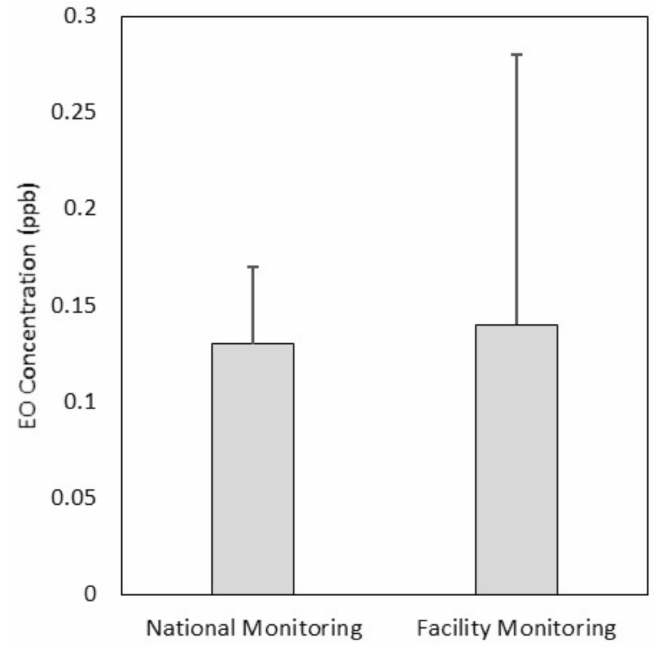
Figure 2. Overall mean (top of box) and SD (whisker) of ambient air EO concentrations across 27 national monitoring locations and across the 27 individual locations aggregated into five back- ground locations for the facilities characterized in this